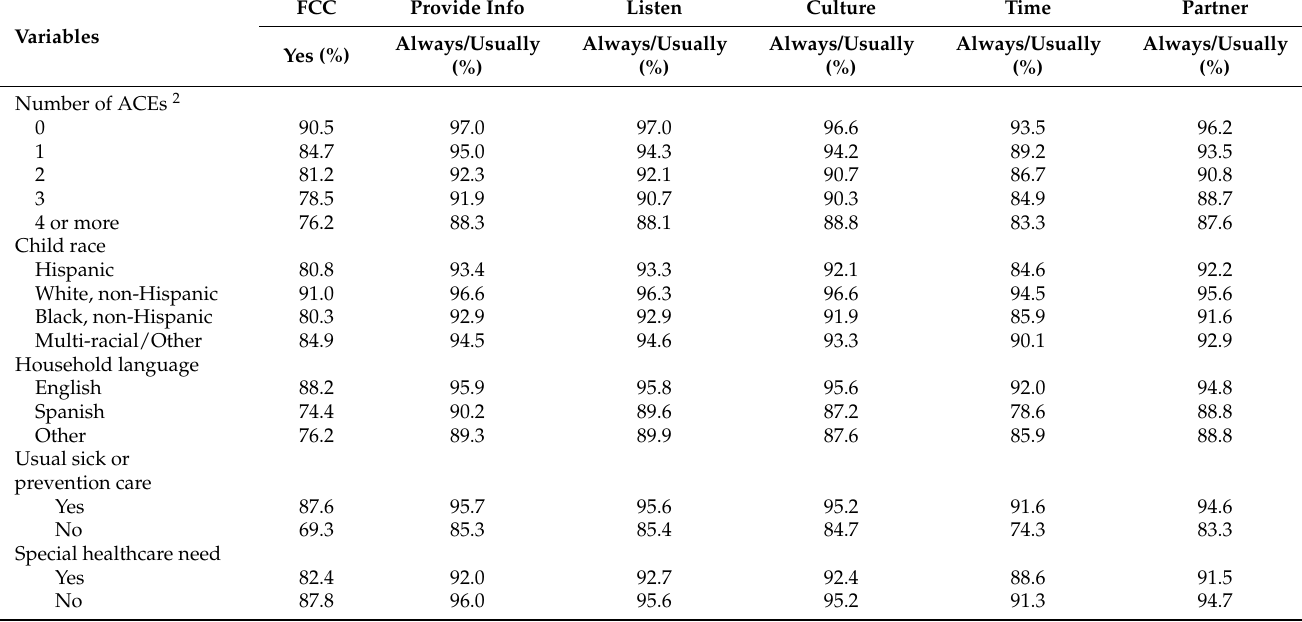
Table 2. Bivariate Analysis of Family Centered Care.